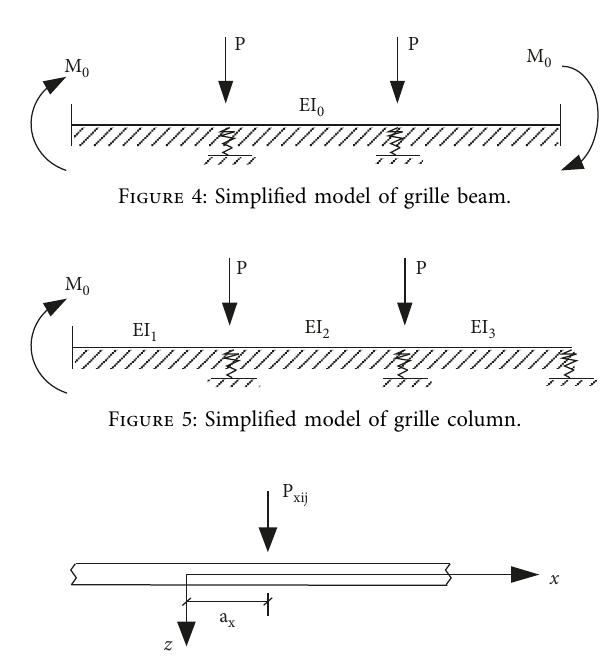
Figure 6: Elastic foundation beam model of grille